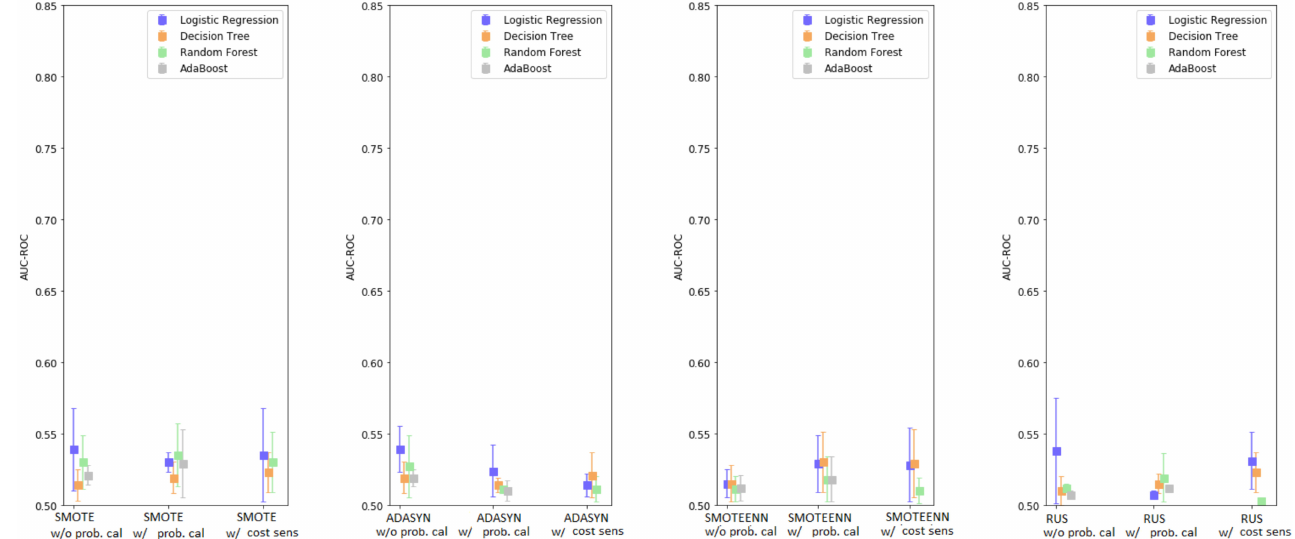
Figure 2. Enhanced base classifiers performance with Monte Carlo data